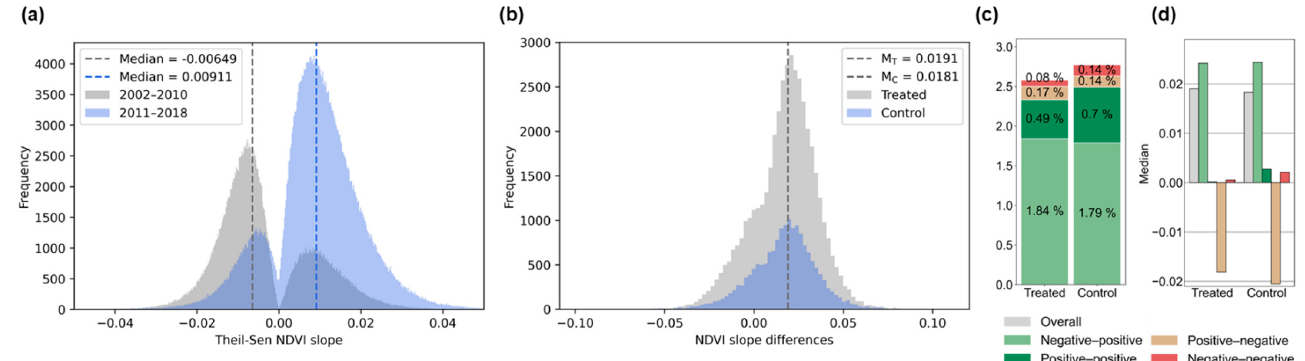
Figure 4. Theil-Sen NDVI trends. ( a ) Distribution of statistically significant (p<0.01) trends for both sub-periods for the total study area; ( b ) Distribution of NDVI trend differences (slope of 2011–2018 minus slope of 2002–2010) for treatment and control areas; ( c ) Proportion of each type of change for all significant pixels and ( d ) Median of NDVI trend differences (slope of 2011–2018 minus slope of 2002–2010) for the overall trend and for each type of change constellation.